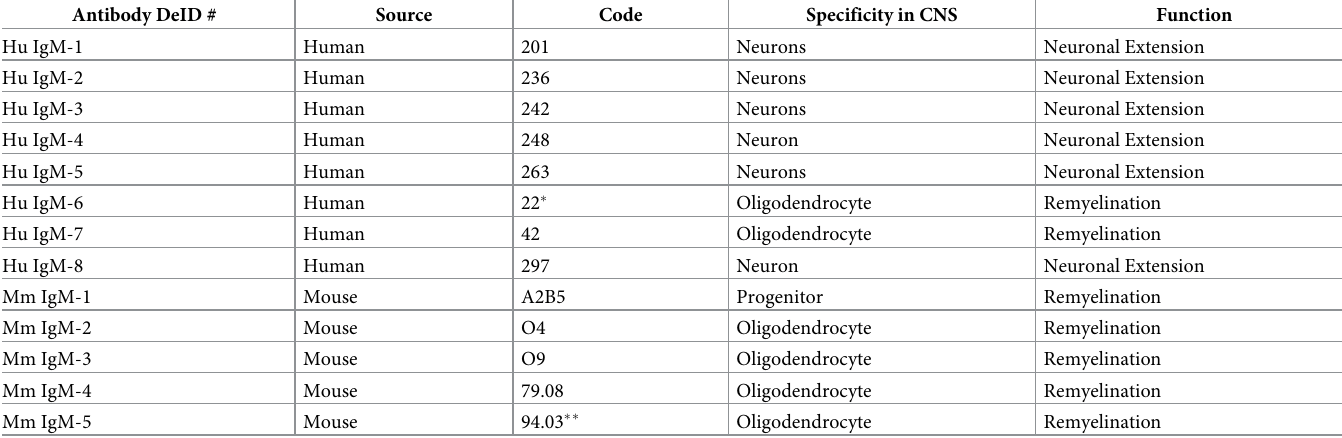
Table 3. List of therapeutic antibodies from Mayo. These antibodies were shipped from Mayo (Rochester, MI) to ASU (Phoenix, AZ) blinded, labeled only by the source (human or mouse) and the number (Antibody ID). The Code, Specificity in CNS and the Function were known only to Mayo prior to unblinding. Human IgM-6 (Code 22) is in human trials for remyelination. Mouse IgM-5 (Code 94.03) was shown to promote remyelination, and was identified as a natural autoantibody. Antibody DeID #